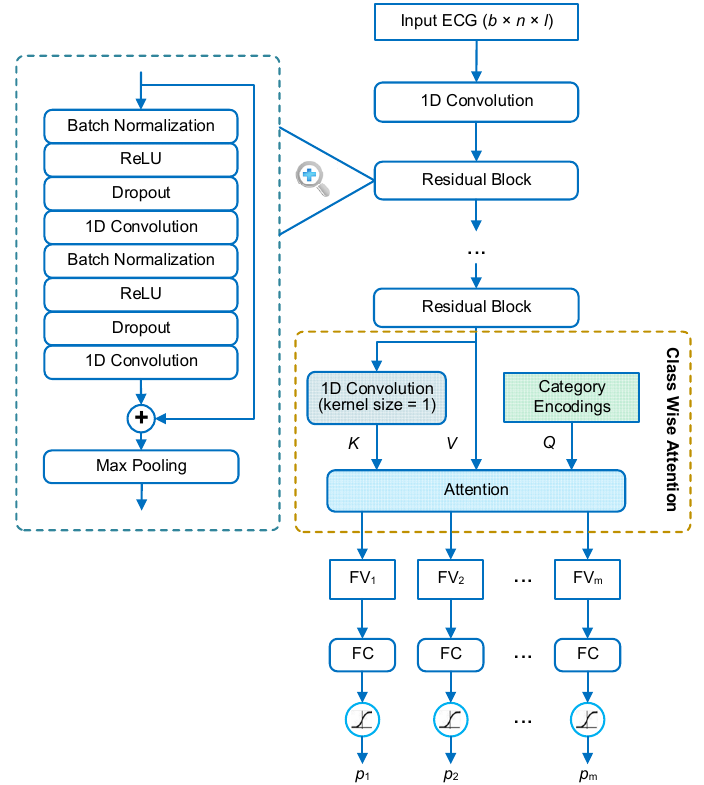
Figure 1. The architecture of our neural network for multi-label electrocardiogram (ECG) classification. The input of the network is an ECG signal in the shape of ( b × n × l ), where b is the batch size, n is the number of sampling points, and l is the number of ECG leads. The input ECG is first processed by a residual neural network to extract a feature map. The feature map is then processed by an attention layer to extract feature vectors. The inputs of the attention layer include keys ( K ), values ( V ), and queries ( Q ). The attention layer outputs a feature vector (denoted by FV i ) for each category (indexed with i ). m is the number of categories that are queried. FV i is finally processed by a dedicated fully connected (FC) layer with sigmoid activation to generate the prediction for category i (denoted by p i